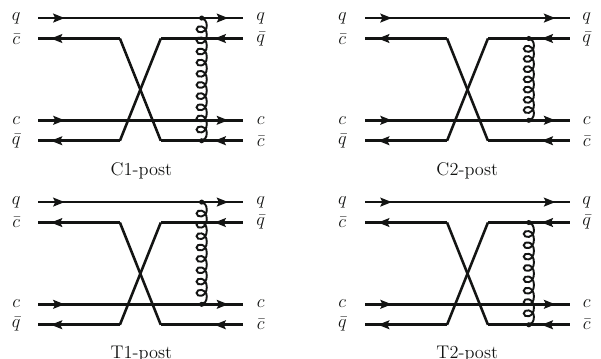
Fig. 1 Prior diagram of scattering process AB → CD . The curly line denotes the interactions between the quarks